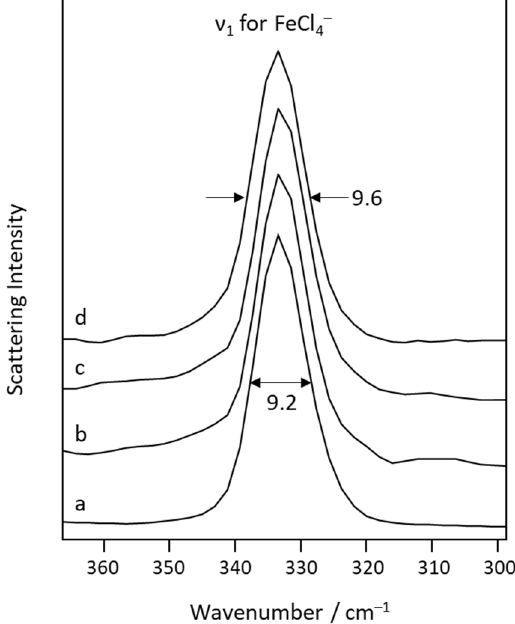
Figure 7. Raman spectra of ( a ) unconfined [C 2 mim]FeCl 4 and [C 2 mim]FeCl 4 confined within ( b ) 8.36, ( c ) 7.36, and ( d ) 5.39 nm mesoporous silica.